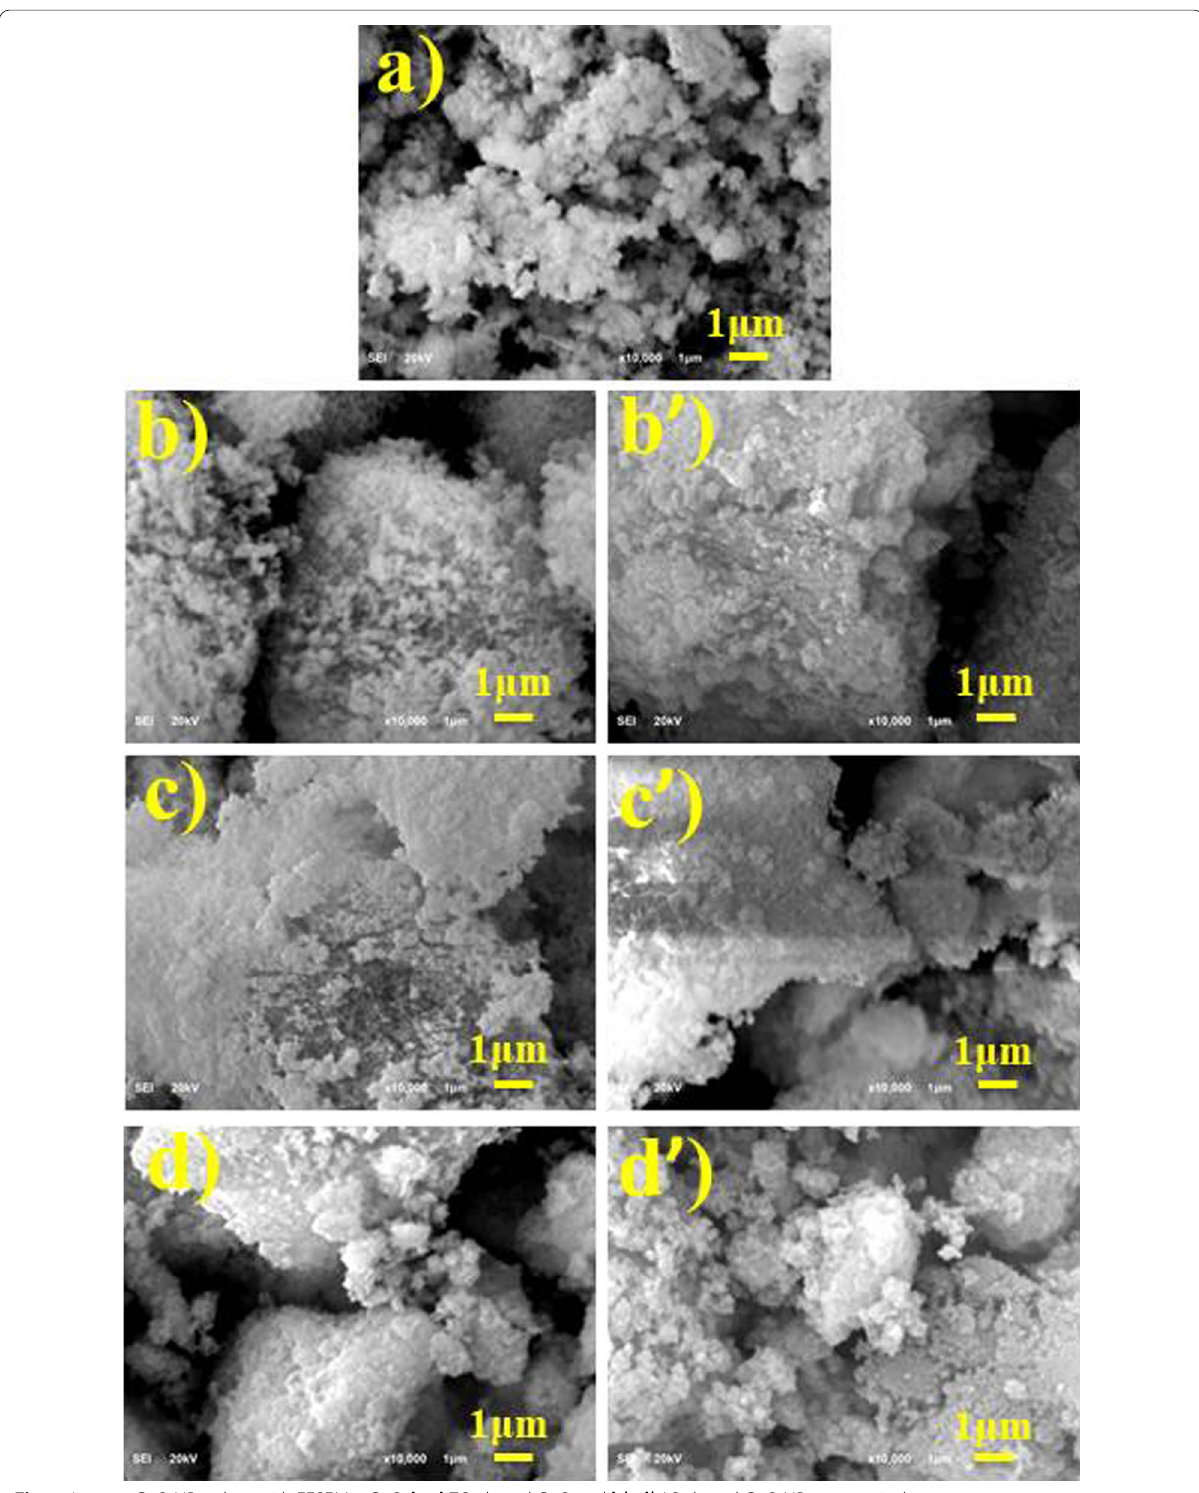
Fig. 5 Images CuO NPs taken with FESEM a CuO, b – d ZO‑doped CuO and b ′ – d ′ AS‑doped CuO NPs,